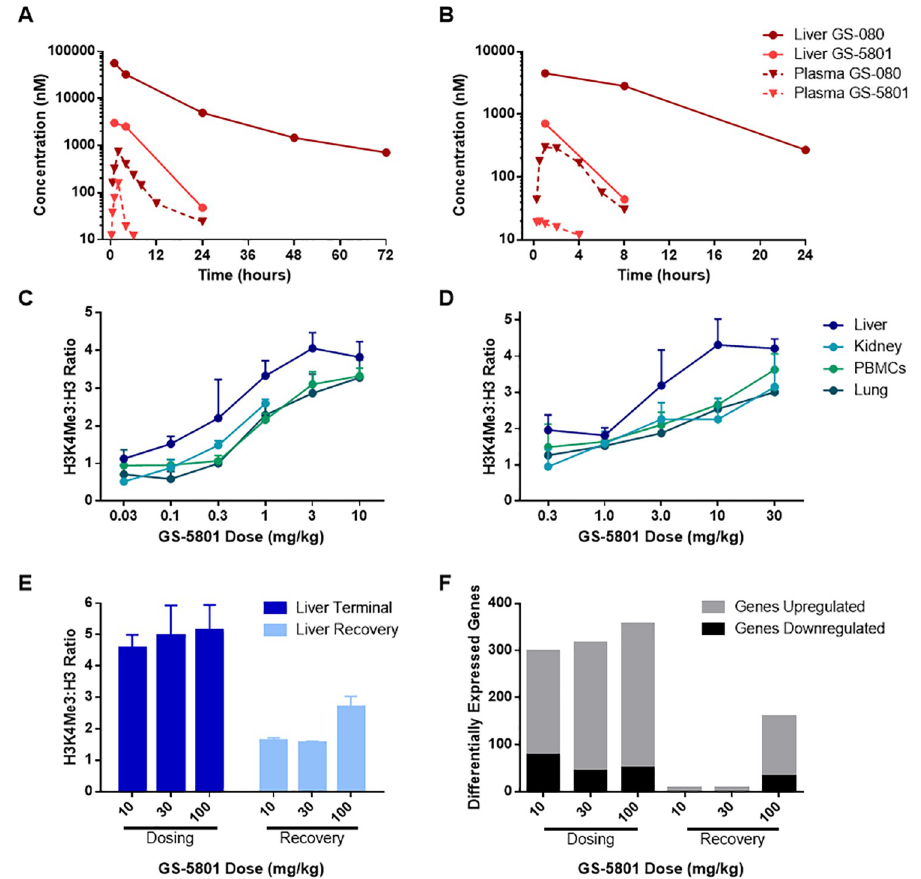
Fig 7. GS-5801 increases H3K4me3:H3 levels preferentially in liver tissue. Sprague Dawley rats (A) and cynomolgus monkeys (B) were dosed once with 1 mg/kg or 2.5 mg/kg GS-5801 p.o., respectively. Amounts of pro-drug (GS-5801) and active parent (GS-080) were measured by LC-MS in liver tissue and plasma at the timepoints shown. (C) Cynomolgus monkeys were dosed p.o. once daily for seven days with 0.03, 0.1, 0.3, 1, 3, or 10 mg/kg of GS-5801. Twenty four hours after the last dose, amounts of H3K4me3 and H3 were measured by ELISA in liver, kidney, PBMCs, and lung. Data are displayed as the average H3K4me3:H3 ratio of GS-5801 treated monkeys relative to vehicle treated monkeys from n = 2–3 animals; error bars represent the standard deviation. (D) Sprague Dawley rats were dosed p.o. once daily for five days with 0.3, 1, 3, 10, or 30 mg/kg of GS-5801. Twentyfour hours after the last dose, amounts of H3K4me3 and H3 were measured by ELISA in liver, kidney, PBMCs, and lung. Data are displayed as the average H3K4me3:H3 ratio of GS-5801 treated rats relative to vehicle treated rats from n = 3 animals; error bars represent the standard deviation. (E–F) Wistar Han rats were dosed p.o. once daily for seven days with 10, 30, or 100 mg/kg of GS- 5801 and a subset of rats from each dose group continued into a seven day off-treatment phase. (E) Twentyfour hours after the last dose or recovery day, amounts of H3K4me3 and H3 were measured by ELISA in the liver. Data are displayed as the average H3K4me3:H3 ratio of GS-5801-treated rats relative to vehicle treated rats from n = 3 animals during the dosing or recovery phases; error bars represent the standard deviation. (F) Transcript levels in rat liver tissue were quantified by RNA-seq (cpm). The number of genes differentially up or downregulated (differential by 2-fold log 2 ; FDR < 0.05) in GS-5801-dosed rats compared to vehicle-treated rats are shown during the dosing phase (24 hours after once daily dosing for seven days) and recovery phase (24 hours after seven days off drug; F).